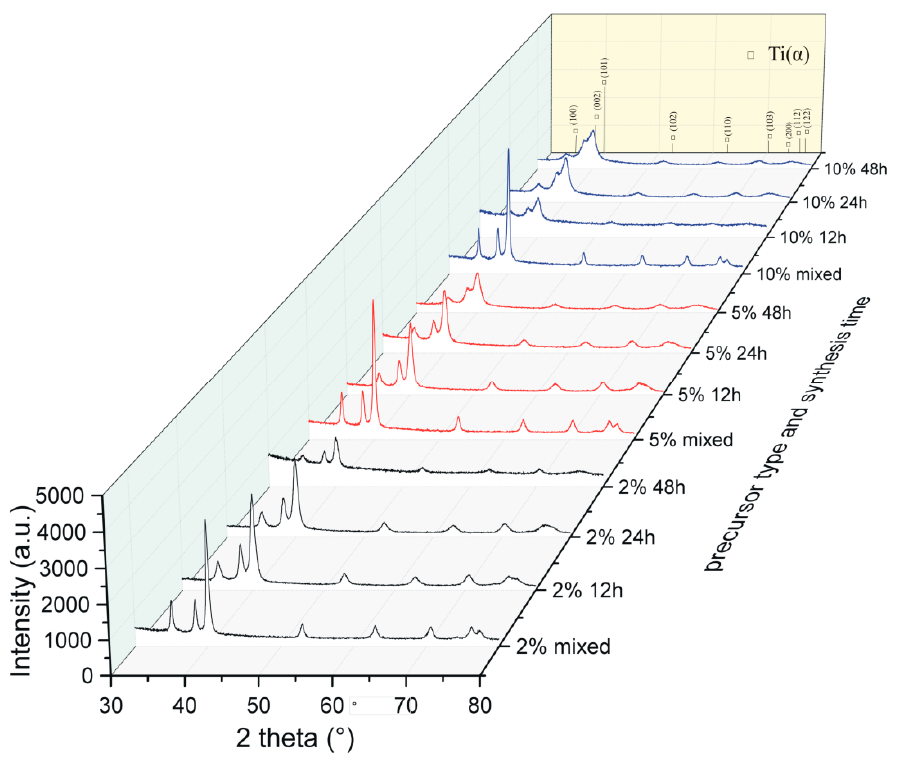
Figure 4. X-Ray diffraction spectra of the precursors during mechanical alloying. Figure 4. X-ray diffraction spectra of the precursors during mechanical